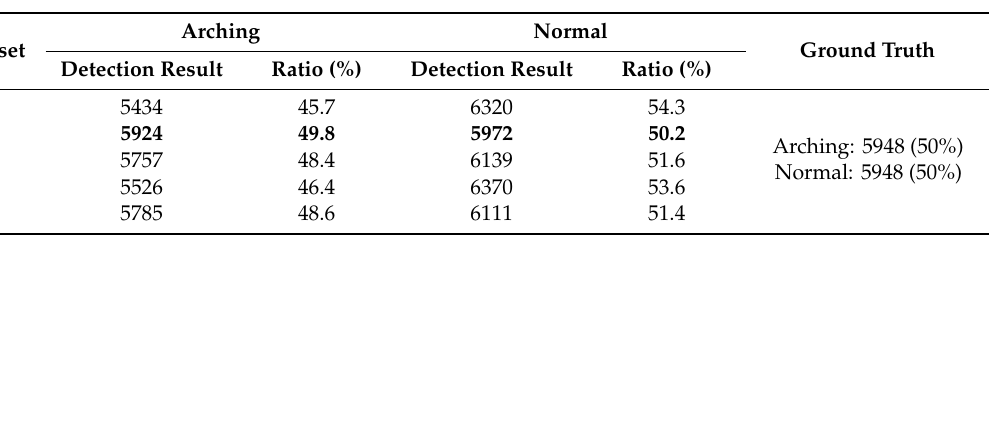
Table 4. Quantity and proportion of each pattern in the testing result (one of five